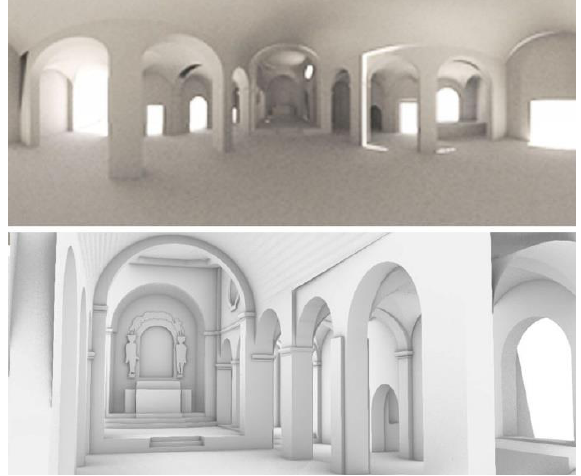
Figure 10. A partial reconstructive hypothesis of the Assunta’s Cathedral for VR